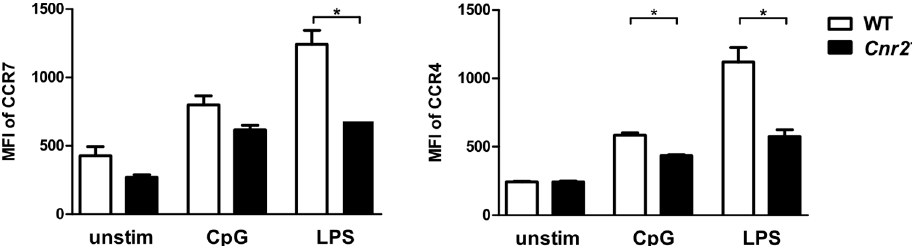
Figure 2. Reduced expression of the chemokine receptors CCR7 and CXCR4 on activated CB2-deficient BM-DCs. BM-DCs from WT (white bars) or Cnr2 − / − (black bars) mice were cultured for 16 h in the absence (unstim) or presence of 1 nmol/mL CpG or 100 ng/mL lipopolysaccharide (LPS). Surface expression of CCR7 and CXCR4 was analyzed by flow cytometry. Data show median fluorescence intensity (MFI) ± SEM ( n = 4–5 animals/group). * p < 0.05.